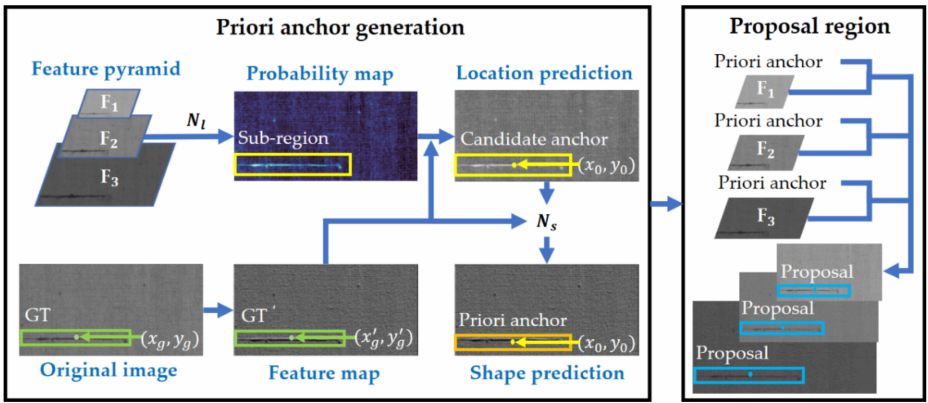
Figure 3. The schematic of the priori anchor generation in the Priori Anchor Convolutional Neural Network